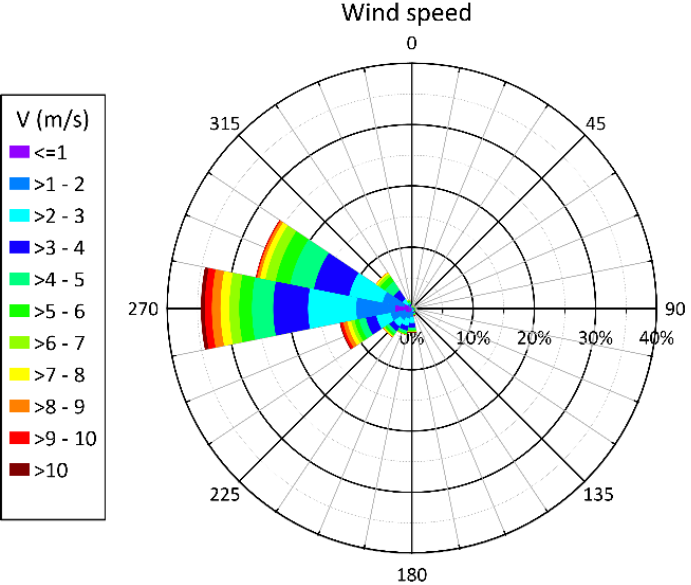
Figure 6. Wind rose diagram for Mazatlan from 1949 to 2009 with data from NCEP/NCAR [42]. Figure 7 shows the yearly maximum values for storm surge (water elevation in front of the coast) obtained from Equation (1).